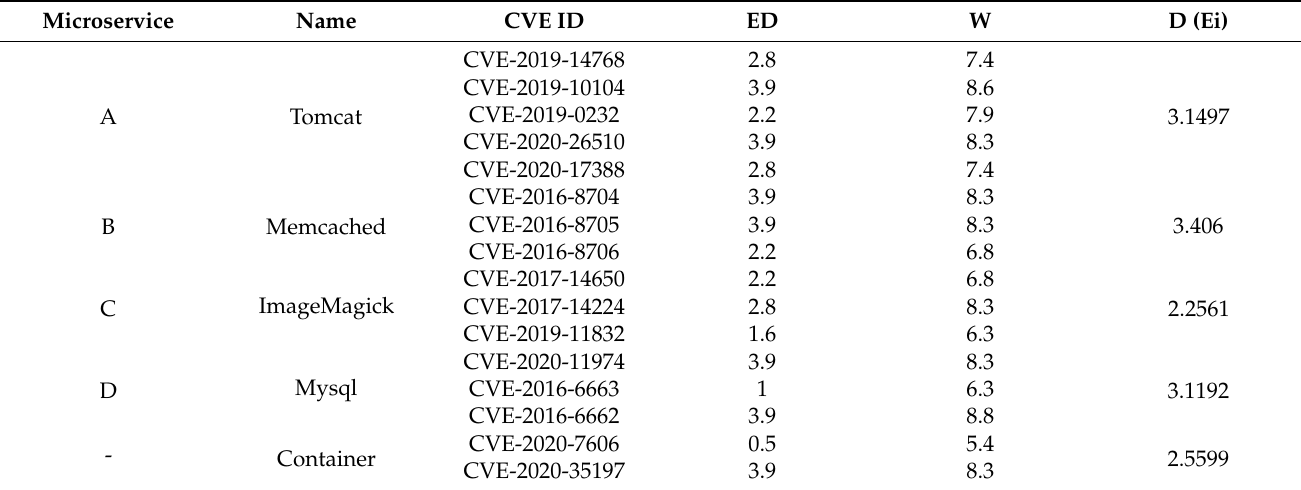
Table 1. Vulnerabilities used in the HSAG